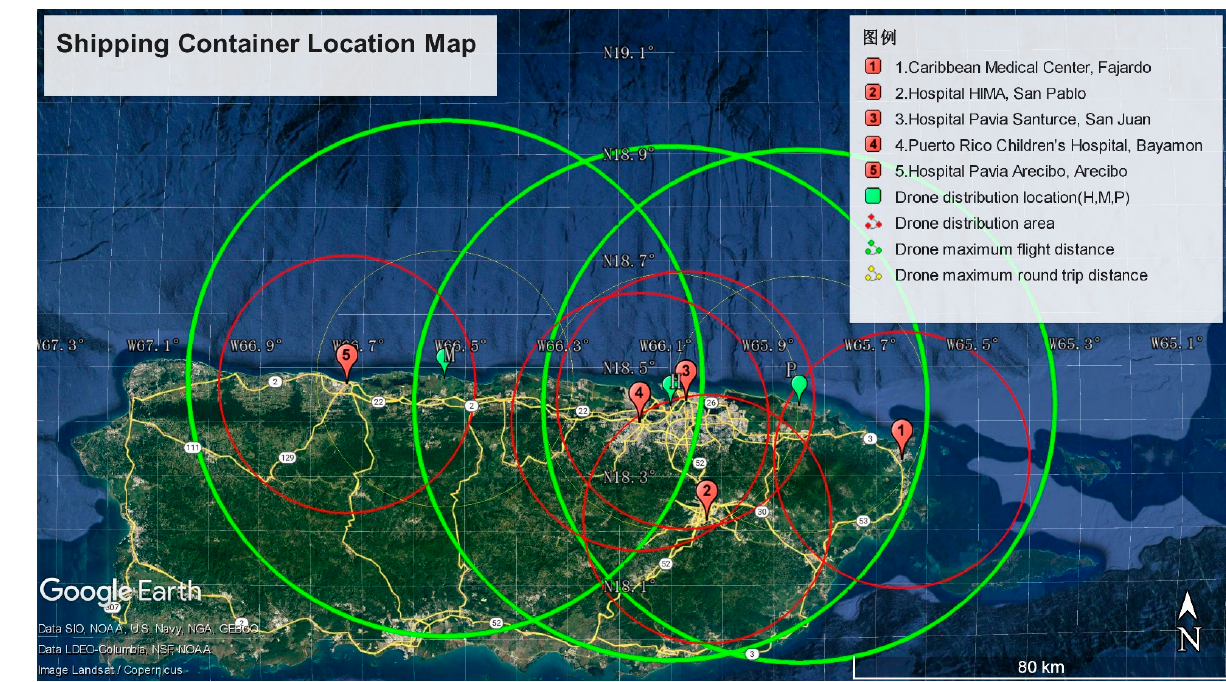
Figure 2. Location map (WGS 48, ESPG:4326).